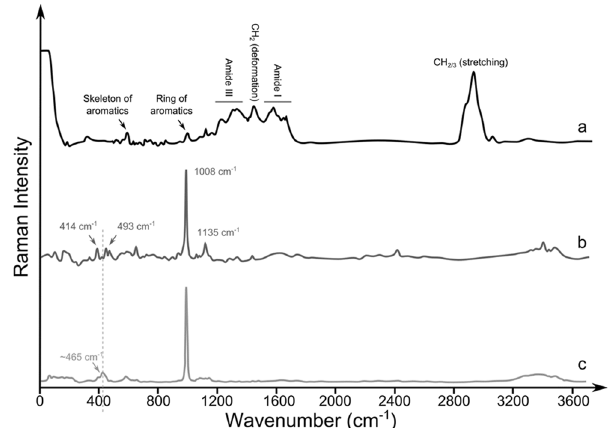
Figure 3. RAMAN spectra of mineralized and non-mineralized Yersinia cells obtained with a 532 nm laser. ( a ) RAMAN spectra of fresh Yersinia cells (black line), ( b ) RAMAN spectra of Yersinia after 6 months mineralization in gypsum (dark grey line) and ( c ) after 6 months of silicification (light grey line). The main peaks for biological molecules ( a ), gypsum ( b ) and silica ( c ) are indicated. The presence of gypsum signals in ( c